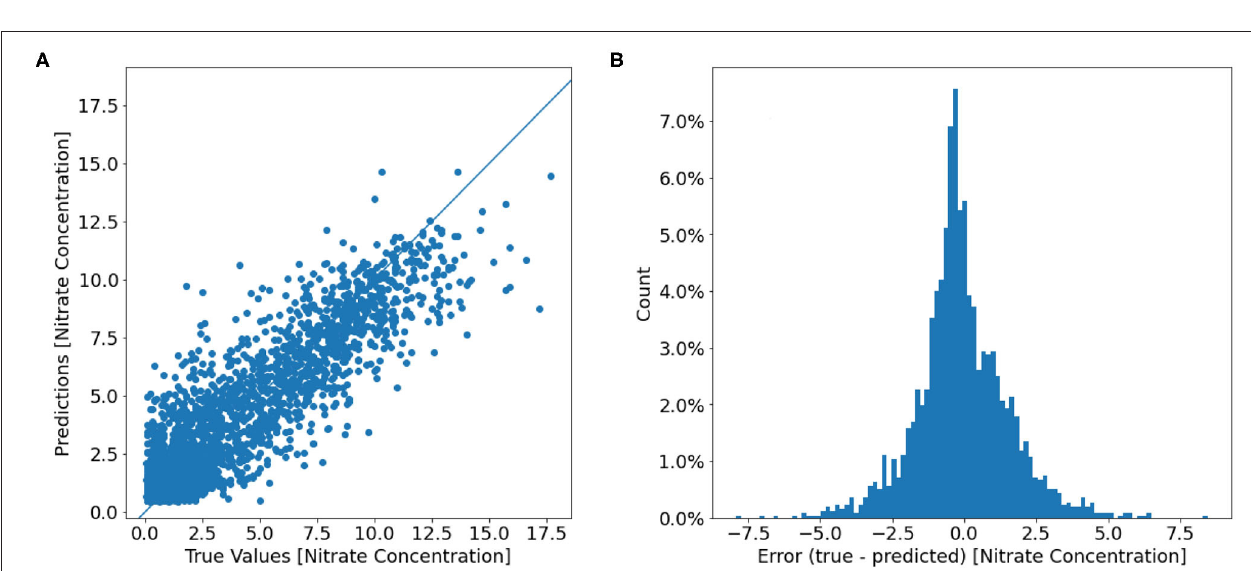
FIGURE 8 | (A) Scatter plot of the true nitrate concentrations ( µ moll − 1 ) from the test dataset against the model predicted oxygen concentrations. (B) A histogram of the prediction error [( true − predicted )]. Counts are displayed as a percentage of the total test data.